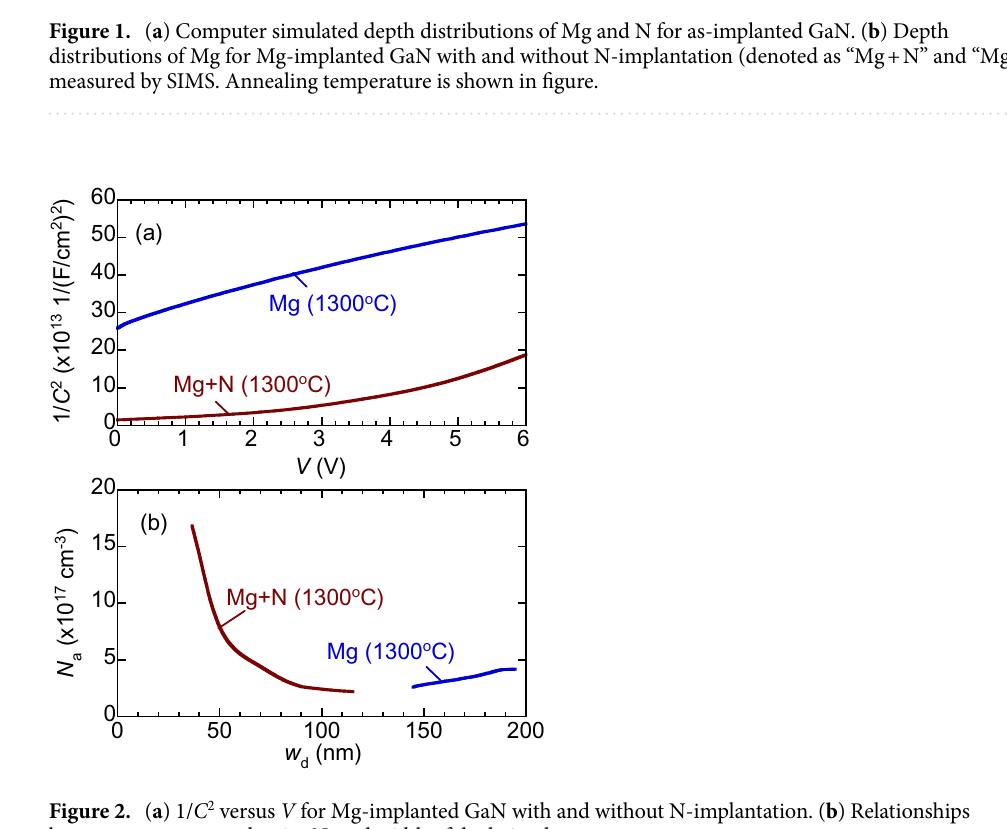
Figure 2. ( a ) 1/ C 2 versus V for Mg-implanted GaN with and without N-implantation. ( b ) Relationships between net acceptor density N a and width of depletion layer w d